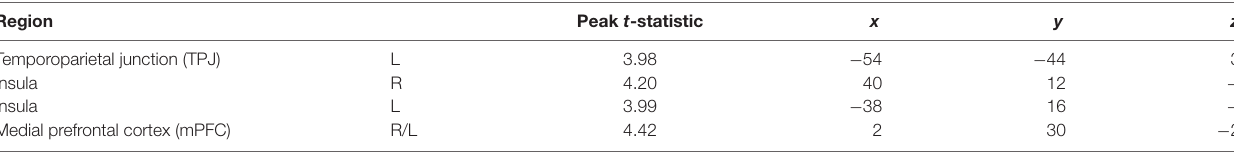
TABLE 3 | Neuroimaging task results, as shown in Figure 3 . Region